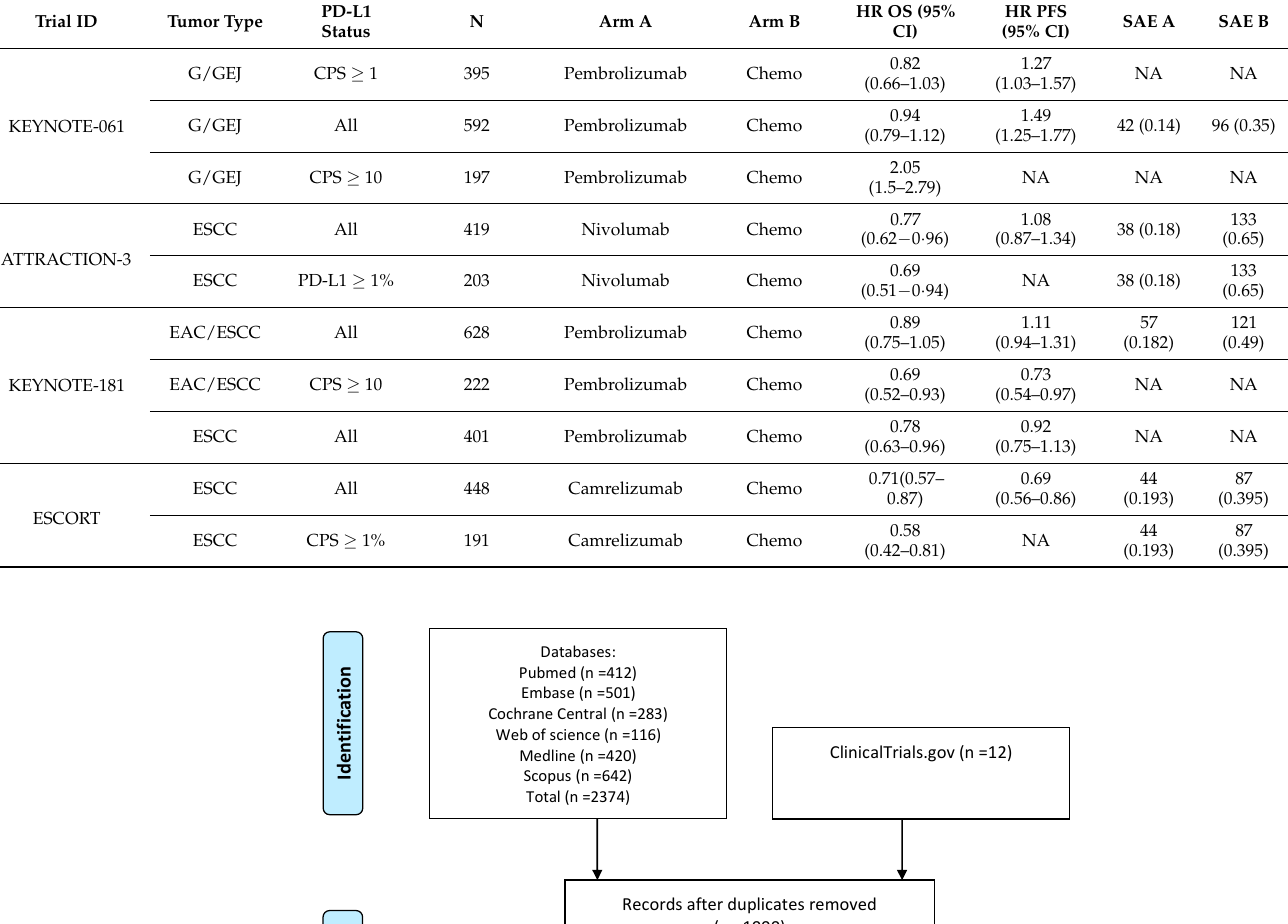
Table A3. Outcomes according to subgroups in the second-line setting.